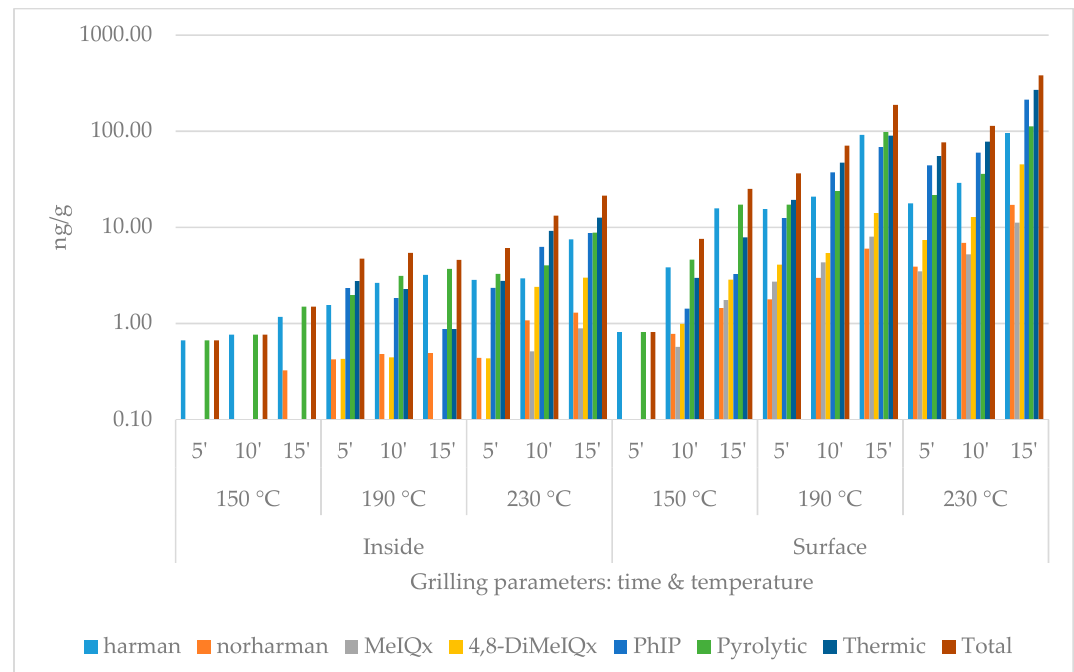
Figure 2 . Heterocyclic amine content of chicken breast with skin grilled with closed top plate. (logarithmic scale).